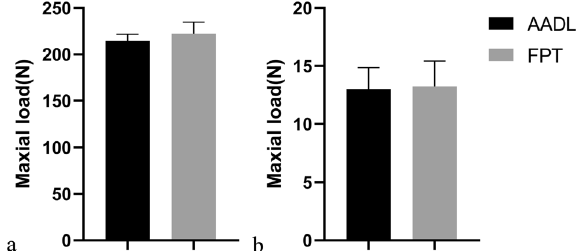
Fig. 8 Mechanical testing results of the specimen. No statistical sig- ni fi cance was shown between groups ( p > 0.05)